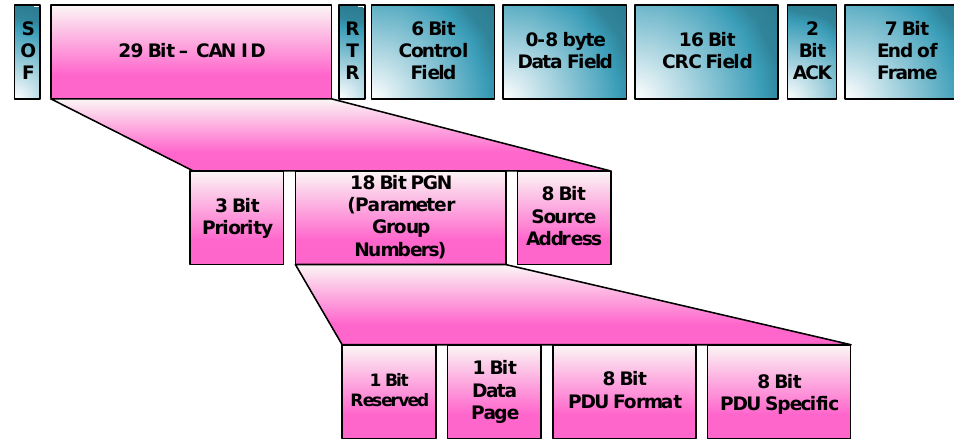
Figure 7. CAN 29-bit message descriptor.